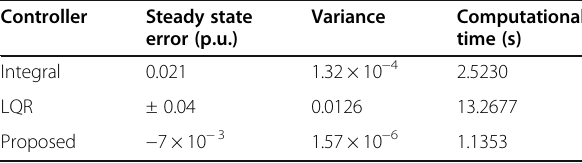
Table 7 Performance comparison of controllers corresponding to a measurement noise variance of